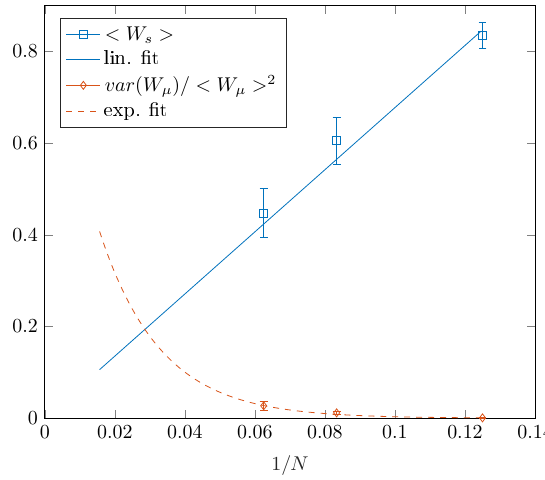
Figure 9 . Lattice spacing dependence of < W s > and variance of W (cid:22) at g = 5 and (cid:22) = 0 :